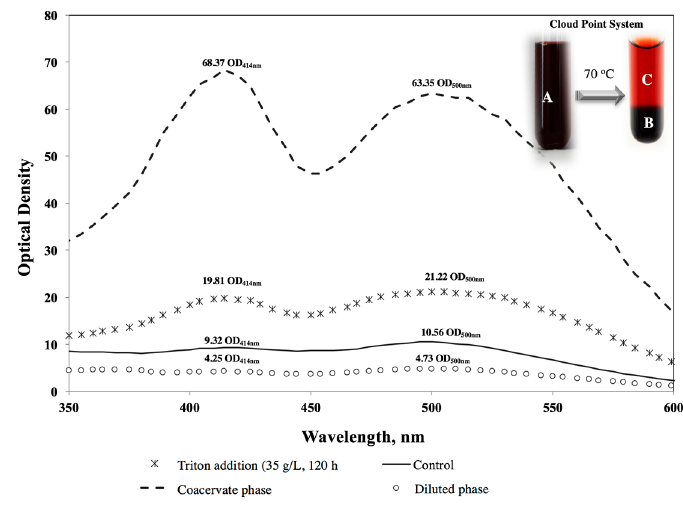
Figure 5. Spectral analysis within the visible wave range performed on the extracellular pigments obtained. Inner Figure: ( A ) the addition of Triton X-100 (35 g/L) at 120 h of fermentation, ( B ) coacervate phase, ( C ) diluted